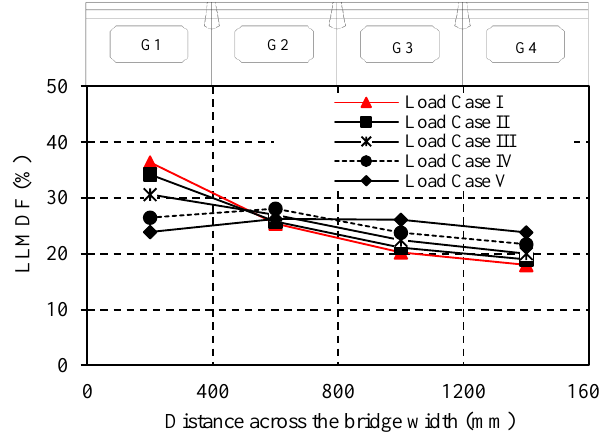
Figure 15. Mid-span LLMDFs for different wheel locations.